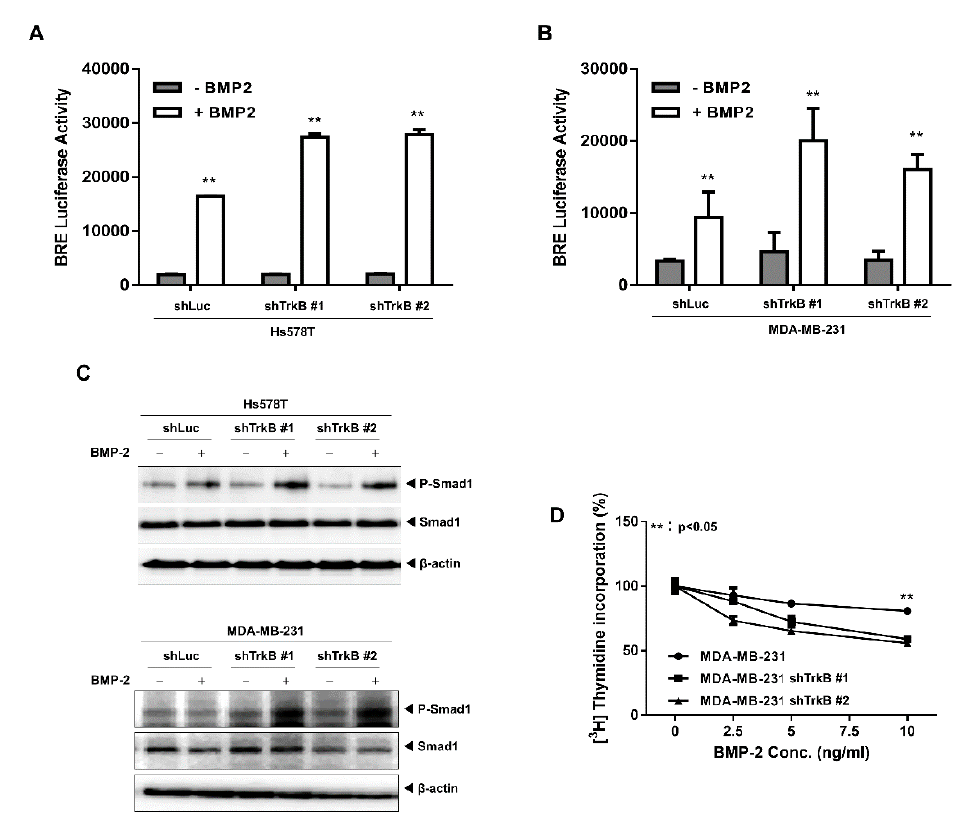
Figure 2. Loss of TrkB in highly metastatic breast cancer cells inhibited BMP signaling. ( A ) BMP-2- responsive BRE Luciferase reporter activity in Hs578T cells transfected with the control or TrkB